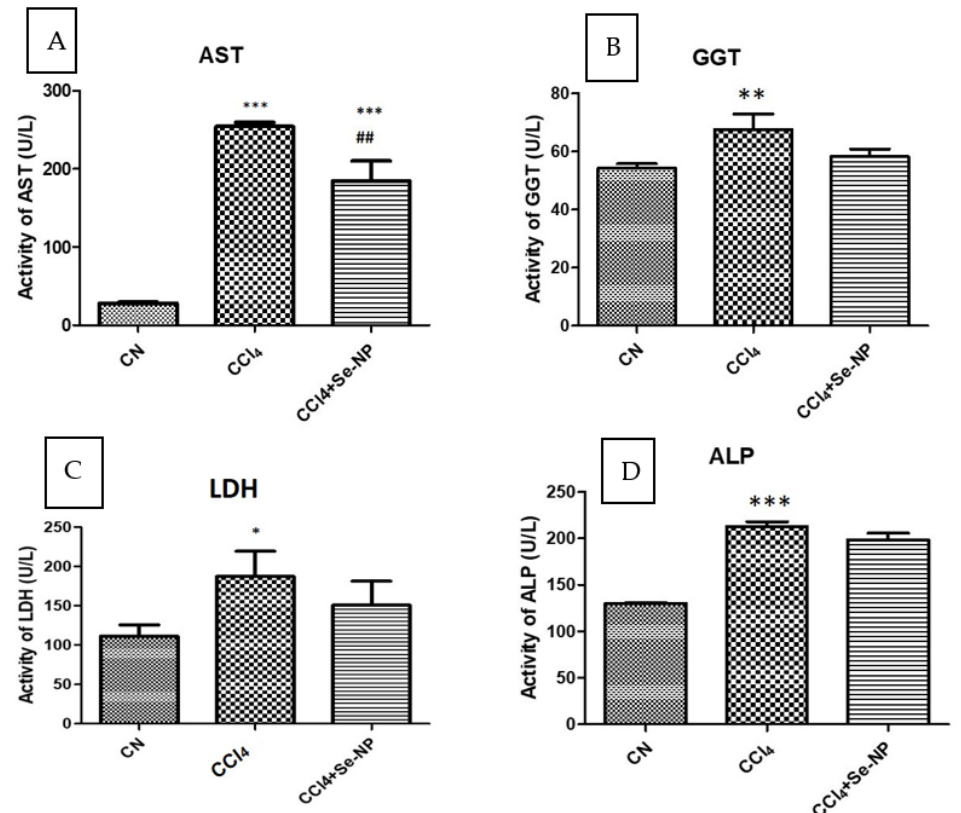
Figure 4. Hepatic function parameters ((plasma aspartate aminotransferase ( A ) and lactate dehydrogenase ( B ), gamma-glutamyltransferase ( C ) and alkaline phosphatase ( D )) in different rat groups. * ( p -value < 0.05) indicates significant differences in rat groups in comparison to control (CN) group animals. # ( p -value < 0.05) reveals significant differences in different rat groups compared to CCl 4 group animals. Also ** and ## indicate p ≤ 0.005 while *** and ### indicate p ≤ 0.001.